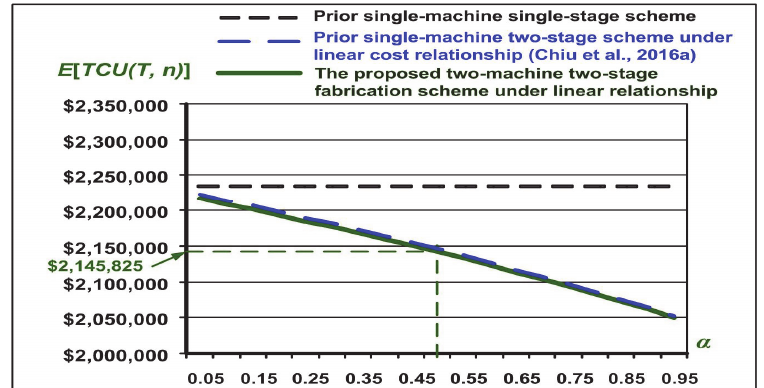
Fig. 7. Performance of E[ TCU ( T, n )] relating to α